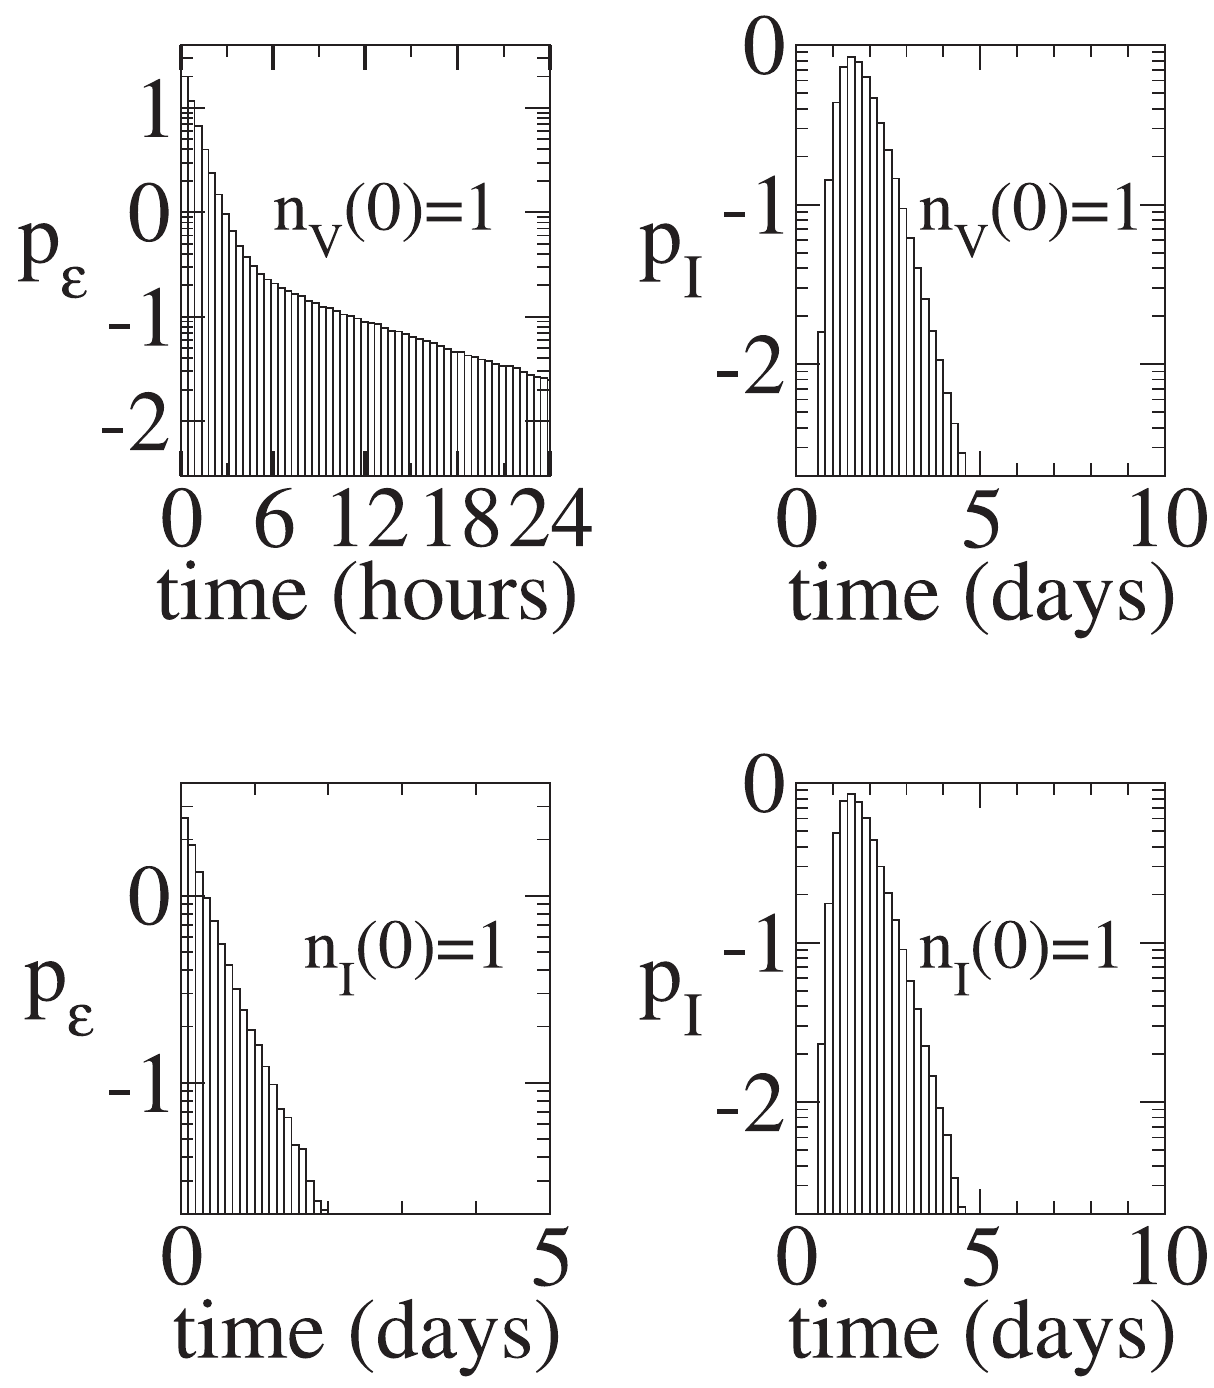
Figure 9. Continuous production model. Top Left: Distribution of times until an infection begun with a single virion goes extinct. The conditional mean time to extinction is about 0 : 08 days for this parameter set. Top Right: Distribution of times until an infection begun with a single virion results in 32 infected cells, given that the infection does not go extinct. The conditional mean time until there are 32 infected cells is 1 : 78 days. Bottom Left: Distribution of times until an infection begun with a single infected cell goes extinct. The conditional mean time to extinction is about 0 : 37 days. Bottom Right: Distribution of times until an infection begun with a single infected cell results in 32 infected cells, given that the infection does not go extinct. The conditional mean time until there are 32 infected cells is 1 : 75 days.